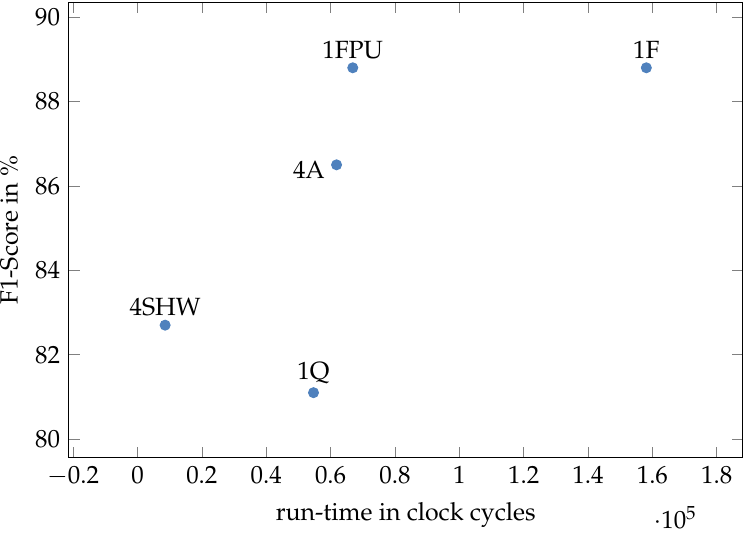
Figure 9. F1-Score ( y -axis) vs. run-time in clock cycles on the AIRISC plotted for the different MicroNet versions. The FP-based MicroNet (1F) achieves the highest F1-Score, though also requires highest run-time. The extended, quantized net (4A) compensates most of the quantization loss in the directly quantized MicroNet (1Q). The specialized accelerate reduce runtime a lot (4SHW).